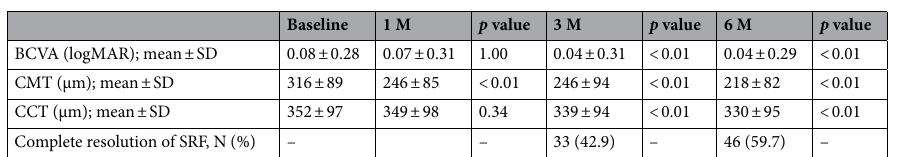
Table 2. Changes of visual acuity and optical coherence tomography findings during follow-up.